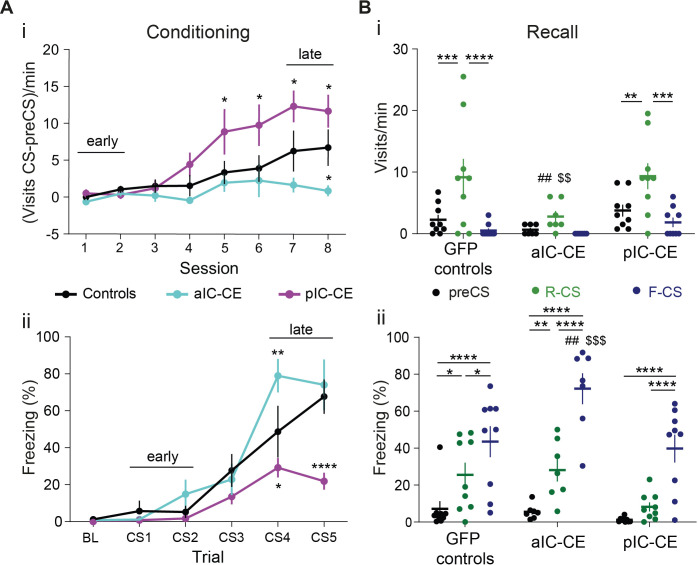
Valence-specific conditioned responses of optogenetic IC–CE manipulation cohorts.(A) (i) Approach behavior in the RC stage quantified by the differential rate of port visits per minute (port visits/min during CS – port visits/min before CS onset)(significant session x treatment interaction in a two-way RM ANOVA, F14,154=3.40, p<0.0001). (ii) Avoidance behavior in the FC stage quantified as the percent of time spent freezing during baseline (1 min) and each CS presentation (10 s) (significant treatment x trial interaction in a two-way RM ANOVA, F10,110=4.71, p<0.0001). (B) Quantification of CS-specific (i) approach (visits/min) (significant effect of treatment in a two-way RM ANOVA, F2,22=3.95, p=0.0343) and (ii) avoidance behavior (percent of time spent freezing) (significant CS x treatment interaction in a two-way RM ANOVA, F4,44=3.17, p=0.0225) during a single recall session with four presentations per R-CS and F-CS, without optogenetic manipulation of aIC/pIC–CE pathways. Holm-Sidak post hoc was used for all analyses. */#/$p<0.05, **/##/$$p<0.01, ***/$$$p<0.001, ****p<0.0001, where ‘#’ indicates comparison to the control and ‘$’ comparison to the other treatment group; nGFP=9 naIC–CE=7, npIC–CE=9. All data presented as mean ± SEM. Full statistical report in Appendix 1—table 1.